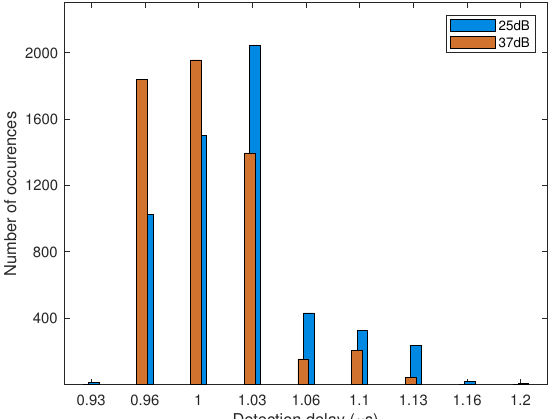
Figure 10. Histogram of detection delay values.